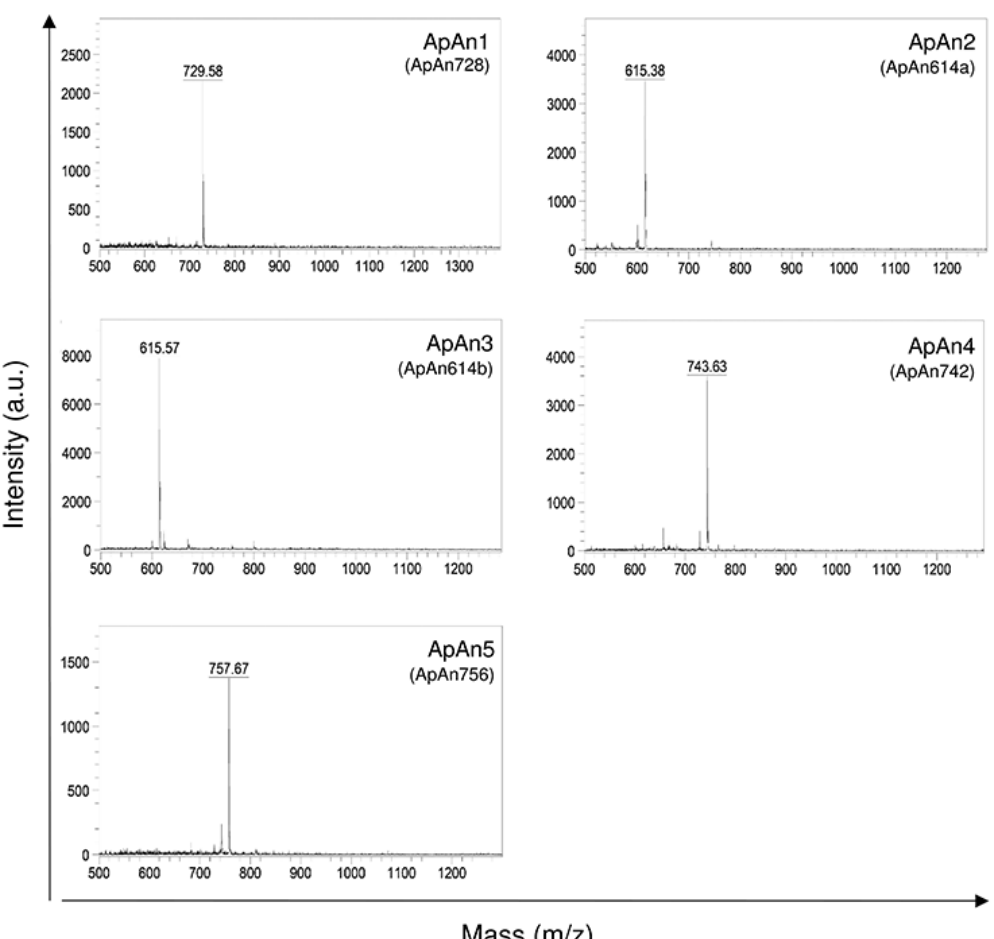
Figure 4. MALDI-TOF/MS spectrum from ApAn1, ApAn2, ApAn3, ApAn4 and ApAn5 (isolated in step 3) obtained in positive reflector mode. Samples in α-cyano-4-hydroxycinnamic matrix. In parentheses, nomenclature assumed according to the observed molecular